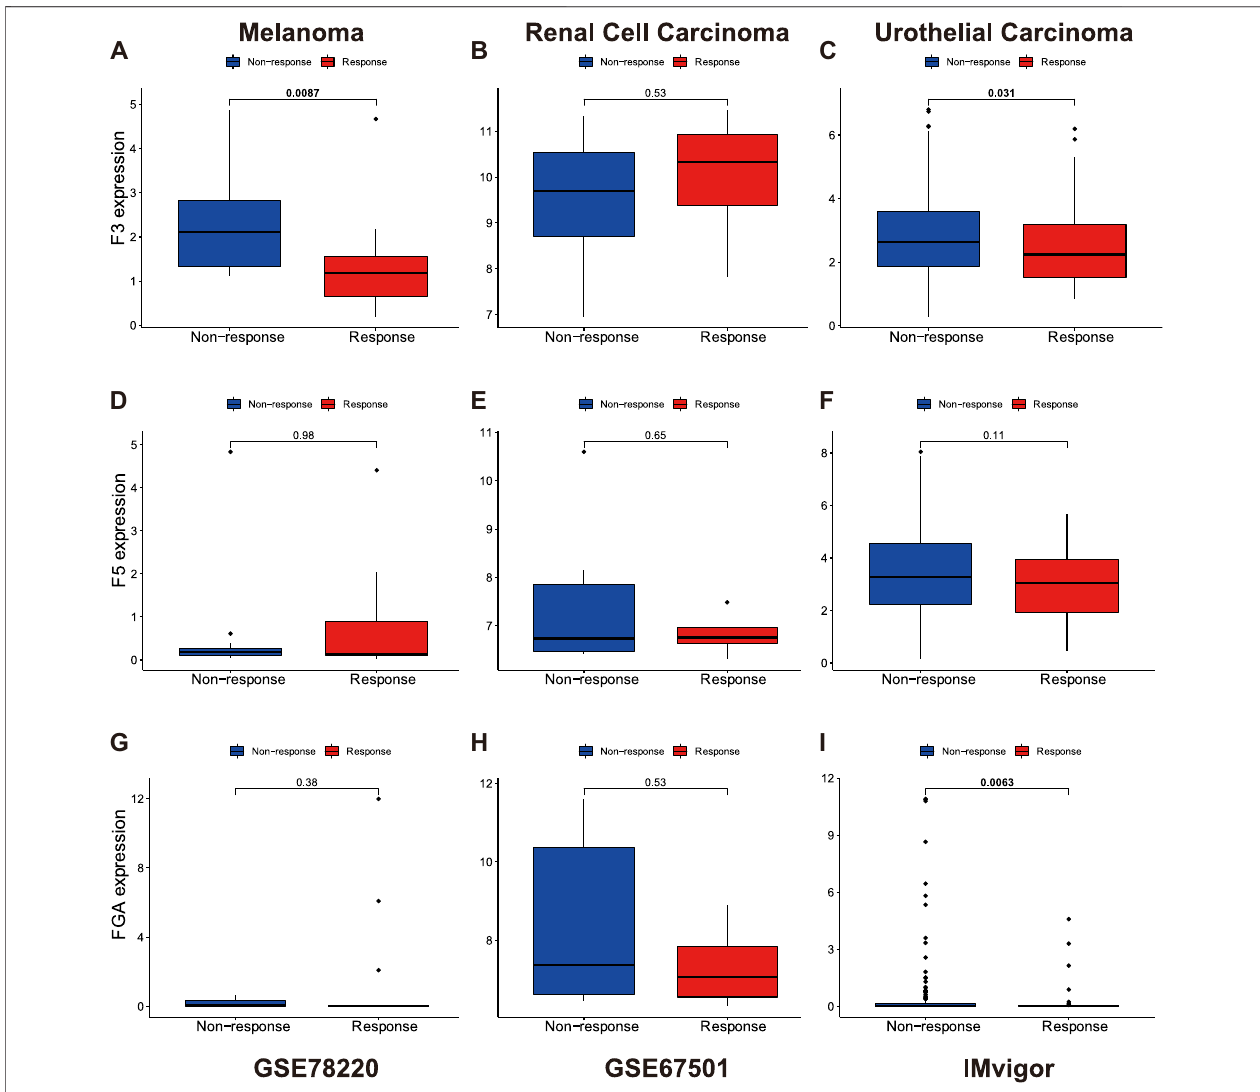
FIGURE 3| Responsesofanti-PD1/PDL1therapyareaffectbyD-dimerrelatedgenesexpression. (A – C) TherelationshipbetweenF3expressionandresponsiveness ofanti-PD1/PDL1therapyinmelanoma,renalcellcarcinomaandurothelialcarcinoma. (D – F) TherelationshipbetweenF5expressionandresponsivenessofanti-PD1/PDL1 therapy, similar with F3. (G – I) The relationship between FGA expression and responsiveness of anti-PD1/PDL1 therapy, similar with